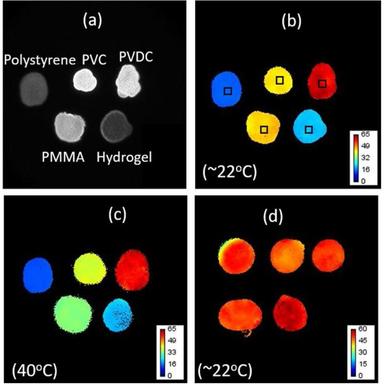
Images of the different phosphorescent coatings spotted on polyester film. (a) Grey scale intensity images; (b) PLIM images at room temperature; (c) PLIM images of the sensors obtained at 40 °C; (d) PLIM images of the sensors obtained under zero O2 condition at room temperature.